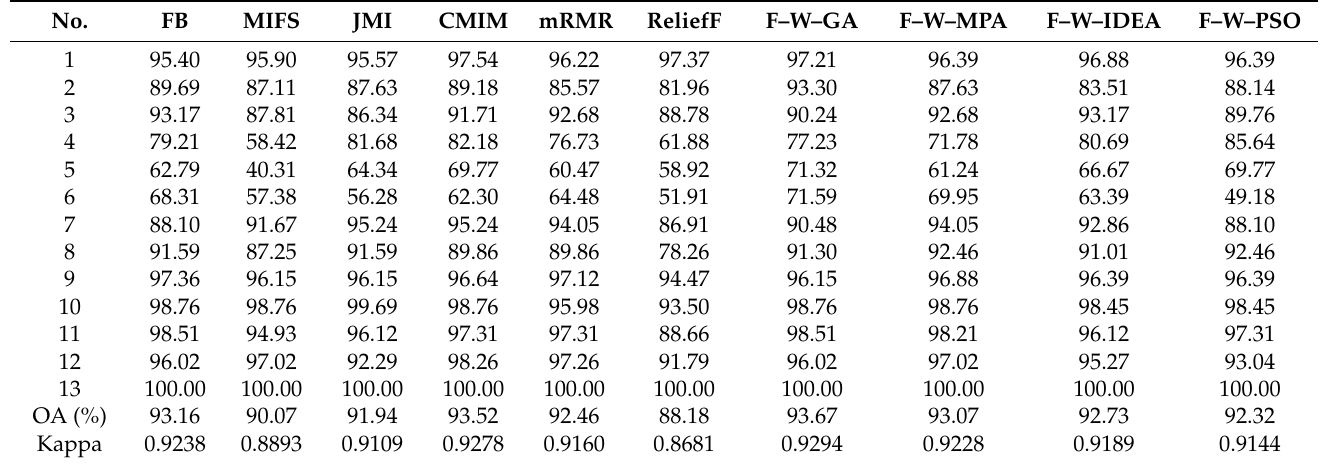
Table 8. The OA, Kappa coefficient, and accuracy of each class for the KSC